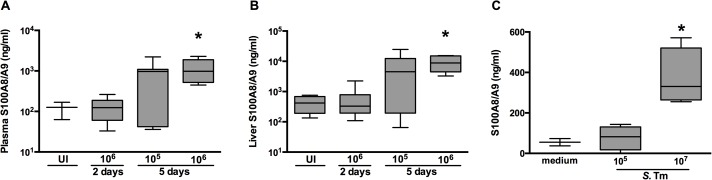
S100A/A9 is up regulated in a murine Salmonella model.Levels of S100A8/A9 complexes measured in plasma (A) and liver homogenates (B) from wildtype (WT) mice orally challenged with 1x105 or 1x106 CFU S. Typhimurium after 0 (uninfected; UI; n = 3 per group), 2 or 5 days of infection (n = 5–8 per group). (C) S100A8/A9 complexes measured in murine whole blood 4 hours after stimulation with 1x105 or 1x107 heat inactivated S. Typhimurium (ATCC) diluted in RPMI to a final volume of 200 μl (n = 4). Data are expressed as box-and-whisker diagrams depicting the smallest observation, lower quartile, median, upper quartile and largest observation. * P<0.05, determined using Kruskal-Wallis testing.